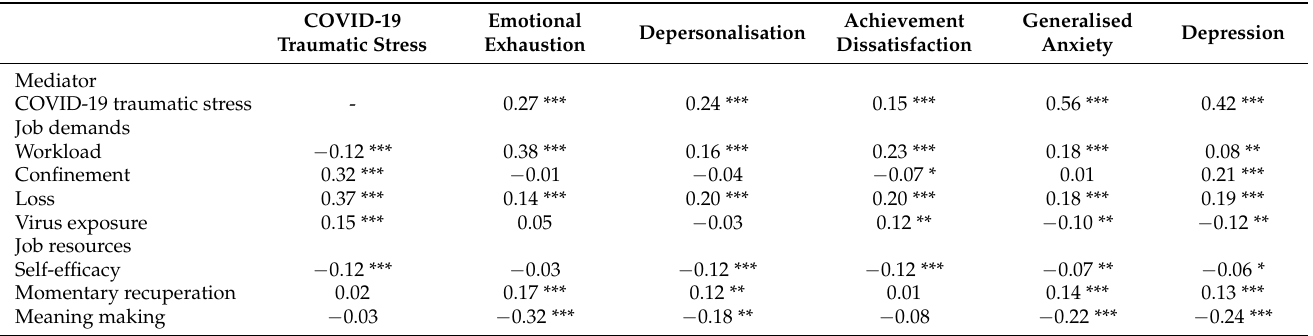
Table 3. Standardised relationships of job demand and resources with mental wellbeing outcomes and COVID-19 traumatic stress as mediator in structural equation path